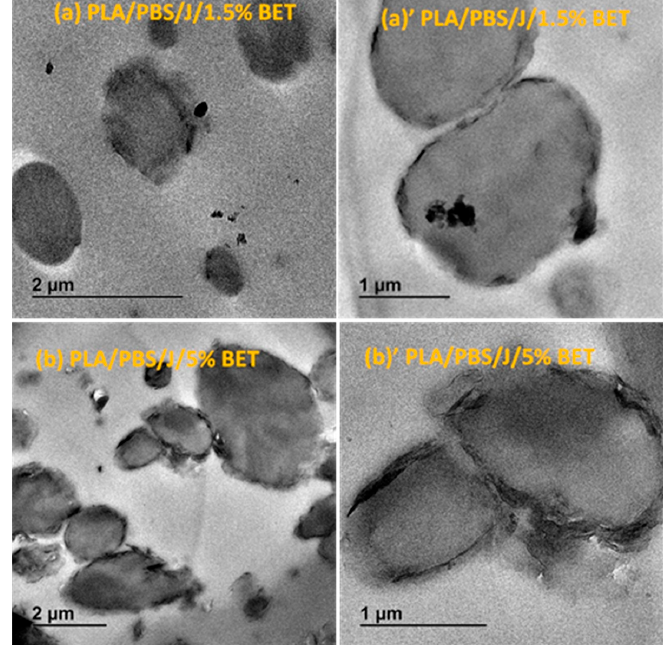
Figure 6. TEM images of the ( a , a’ ) PLA/PBS/J/1.5% BET and ( b , b’ ) PLA/PBS/J/5% BET blends. ( a’ ) and ( b’ ) are the high magnification localized images of 1.5 wt % BET (scale bar = 1 μ m) and 5 wt % BET (scale bar = 1 μ m) blends. BET is Betsopa™ and J is Joncryl.